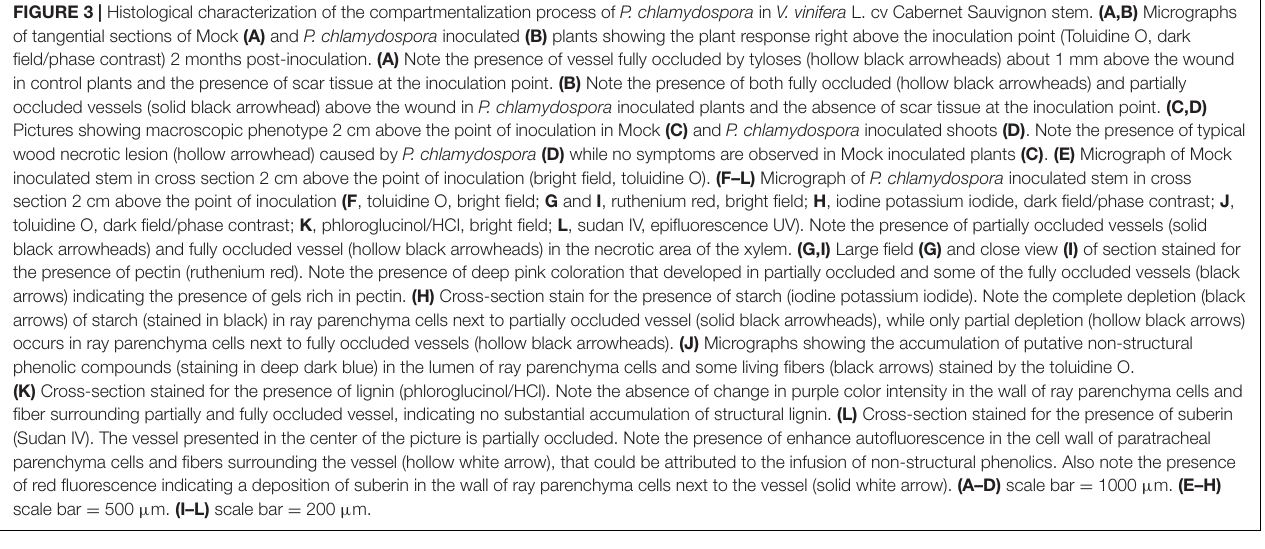
Frontiers in Plant Science |